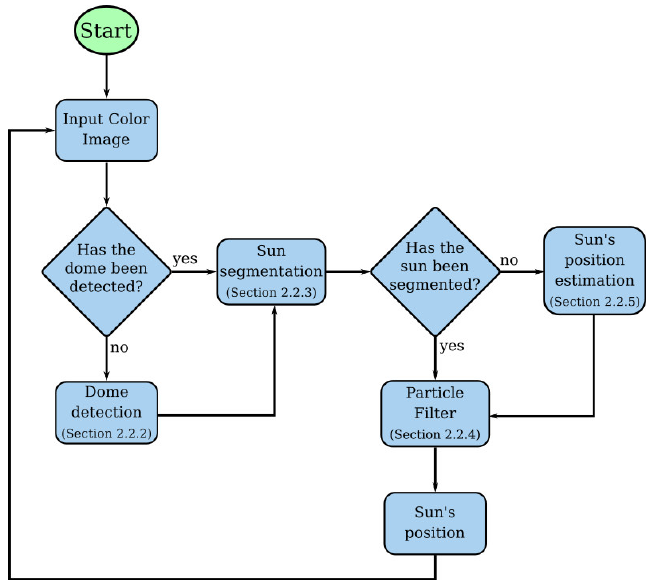
Figure 2. Sun position detection